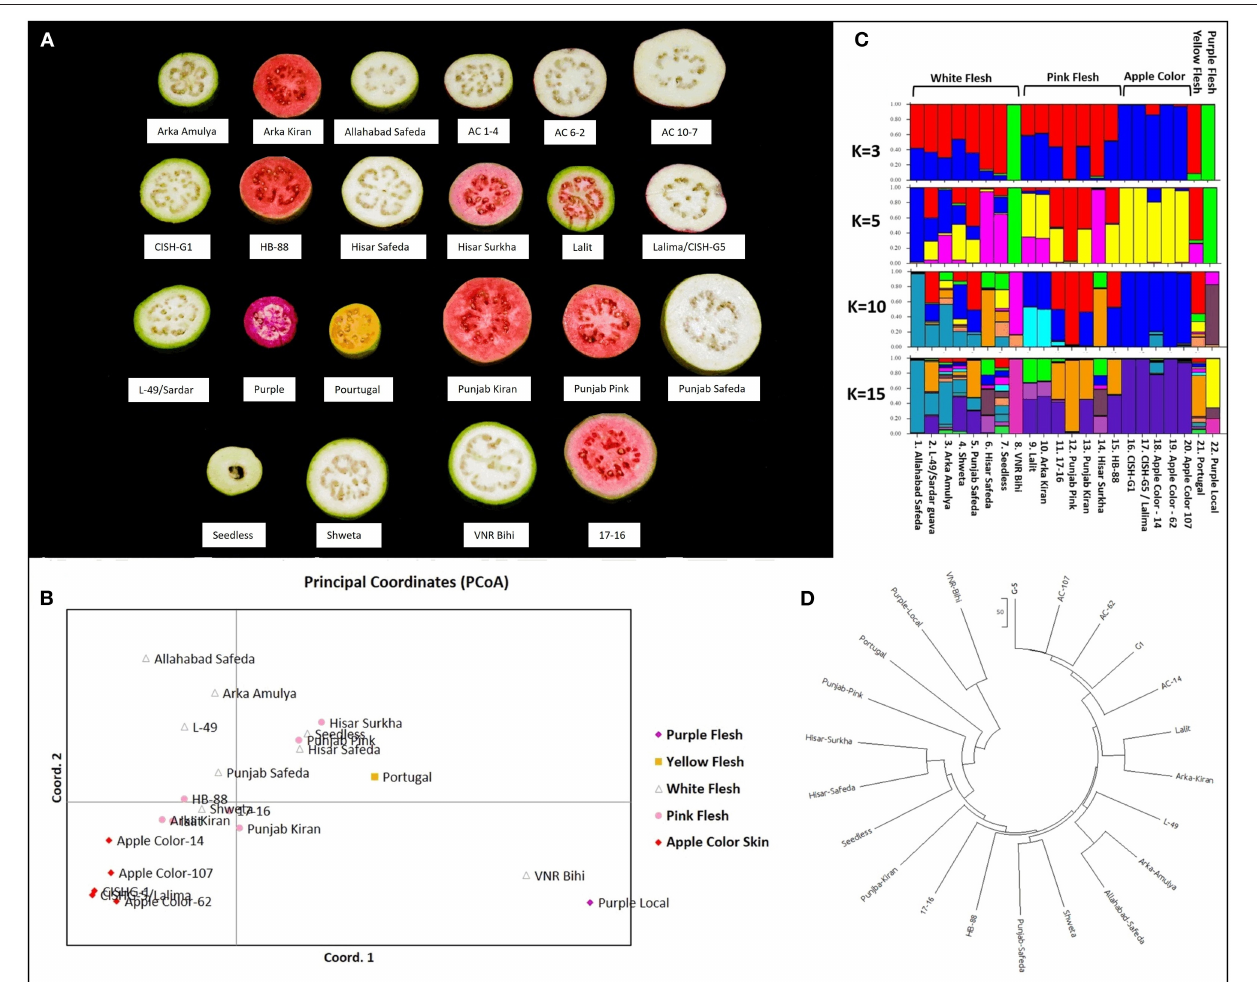
FIGURE 8 | Diversity analysis of Psidium guajava in the 22 cultivars. (A) Phenotypic variability in five flesh/peel color variable cultivars. (B) Principal coordinate analysis computed with GenAlEx. (C) STRUCTURE analysis assuming admixture model with assumed structures as 3, 5, 10, and 15. (D) Neighbor-joining tree constructed with MEGA X (with the sum of branch length =